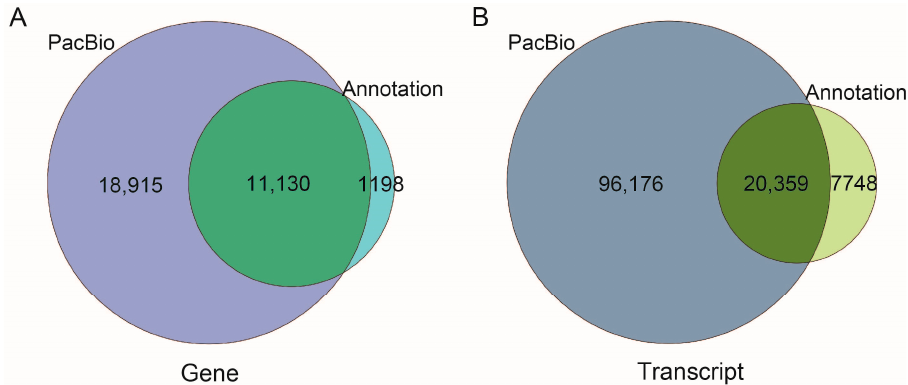
Figure 1. Comparison of transcripts ( A ) and genes ( B ) generated by the PacBio sequencing and A. mellifera genome annotation.